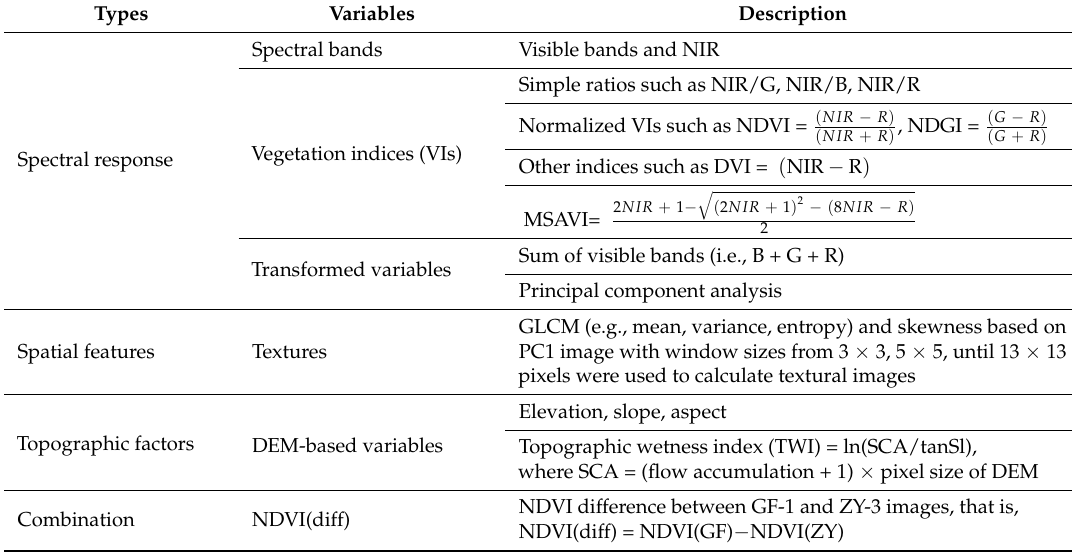
Table 1. Variables used in this